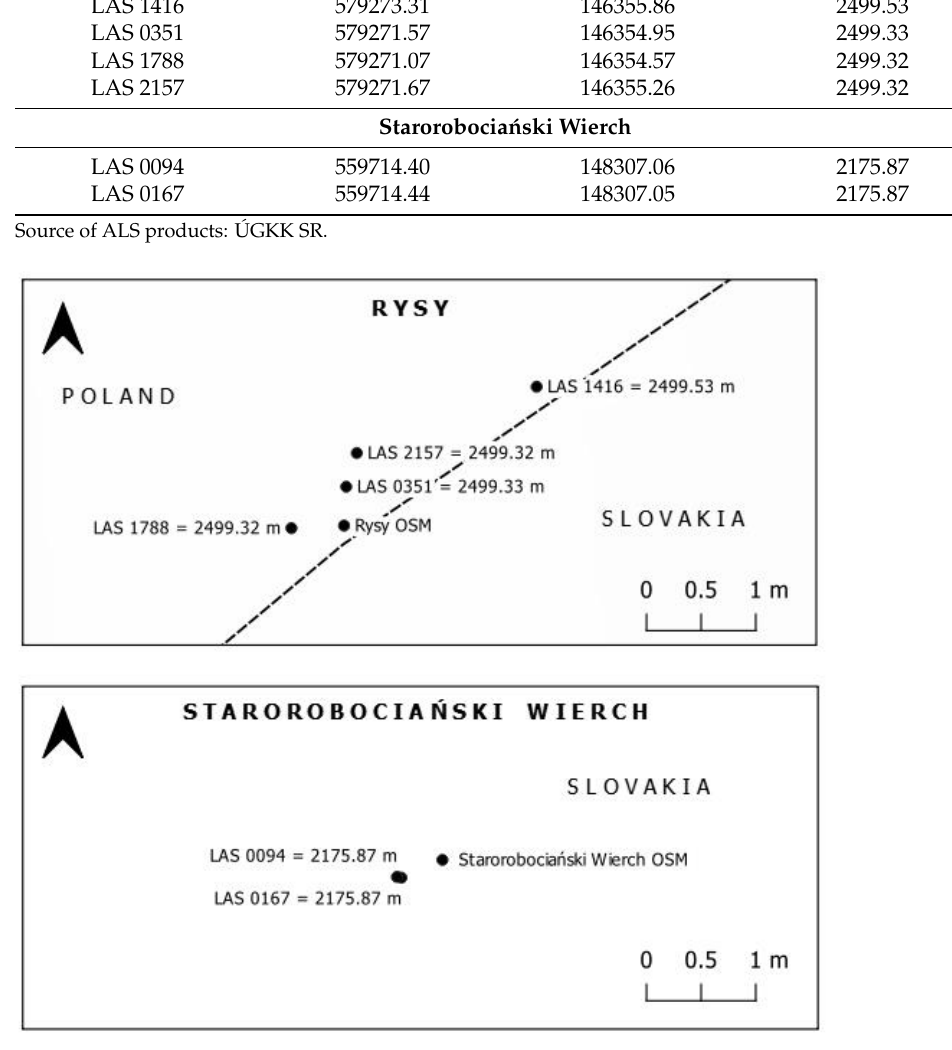
Figure 2. Location of the highest Ground points in relation to OSM (OpenStreetMap)